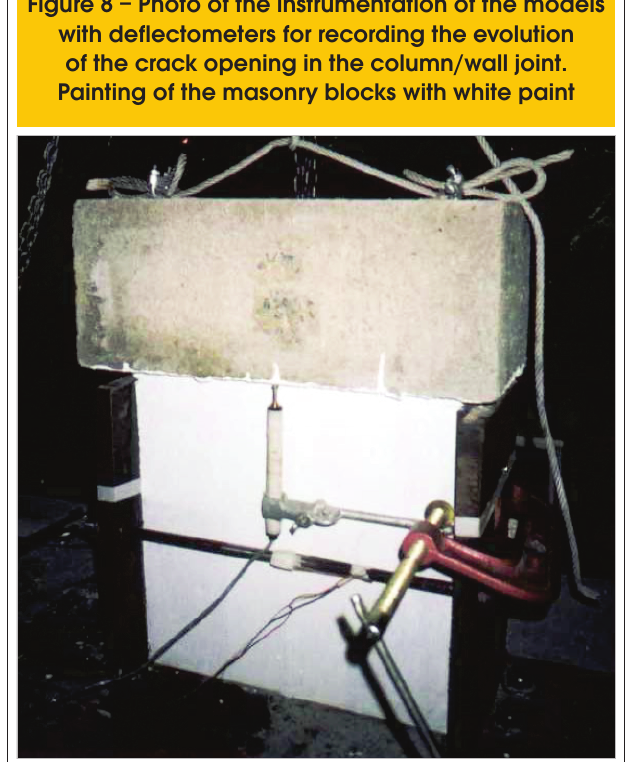
Figure 8 – Photo of the instrumentation of the models with deflectometers for recording the evolution of the crack opening in the column/wall